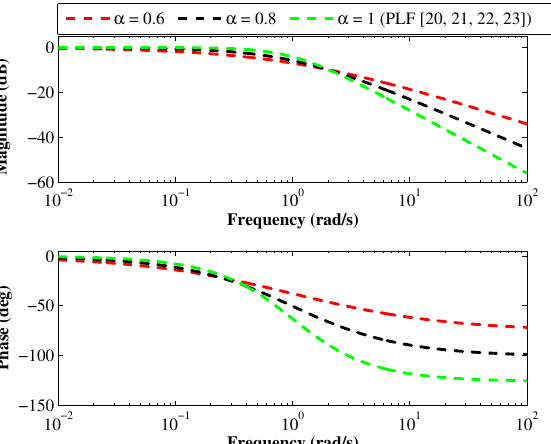
Figure 2. Magnitude and phase responses of the theoretical FLPF for different values of α with β =